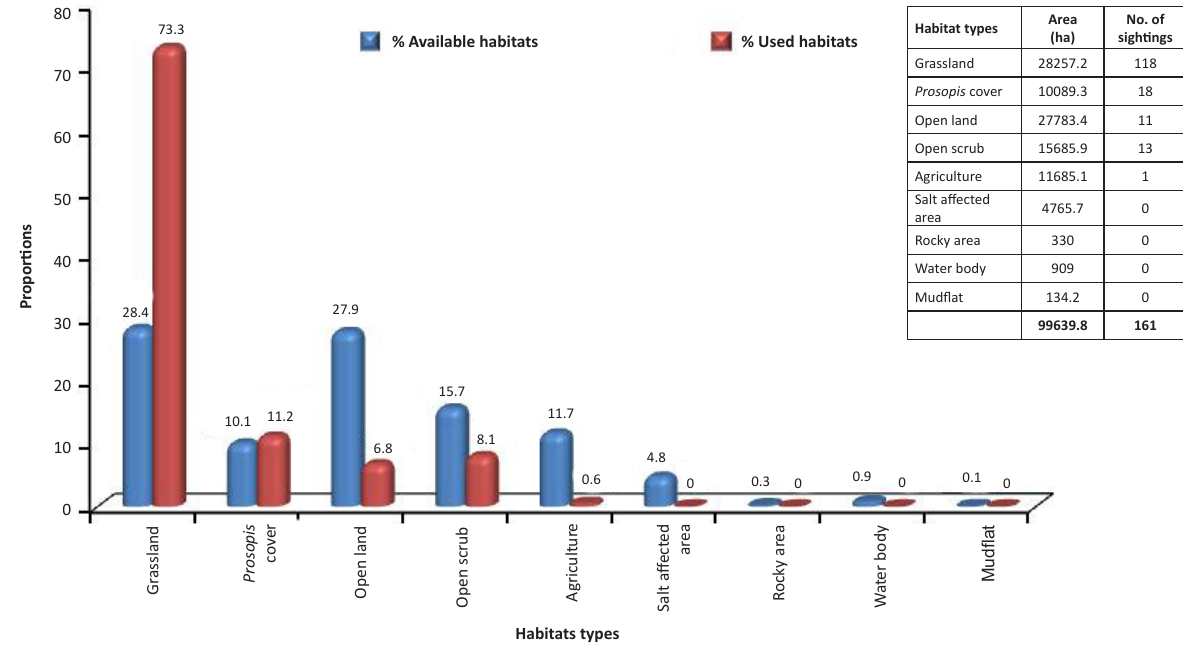
Figure 2. Proportional availability and use of various habitat types in the distribution range of GIB in